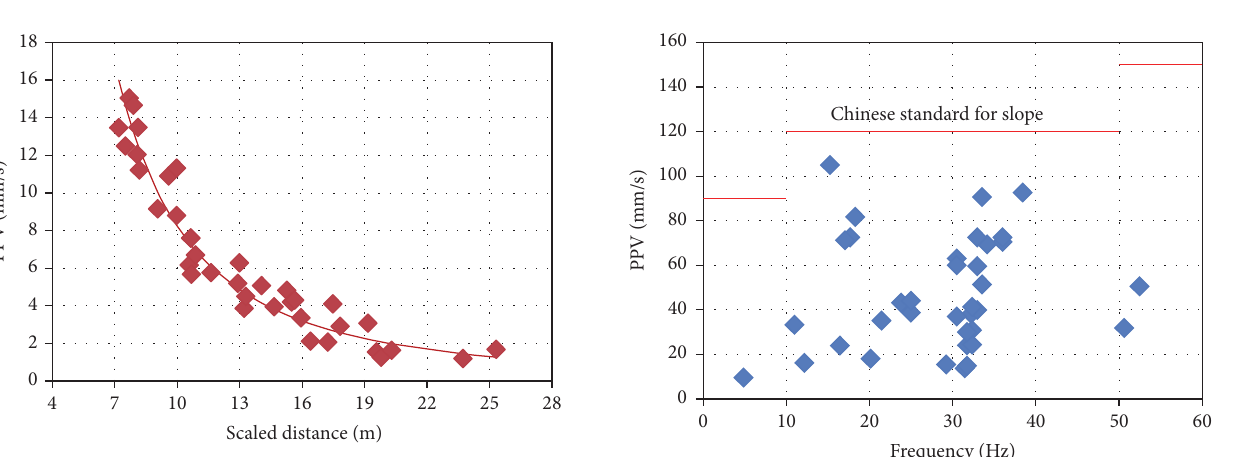
Figure 5: Relations between PPV and the scaled distance for underground vibrations.